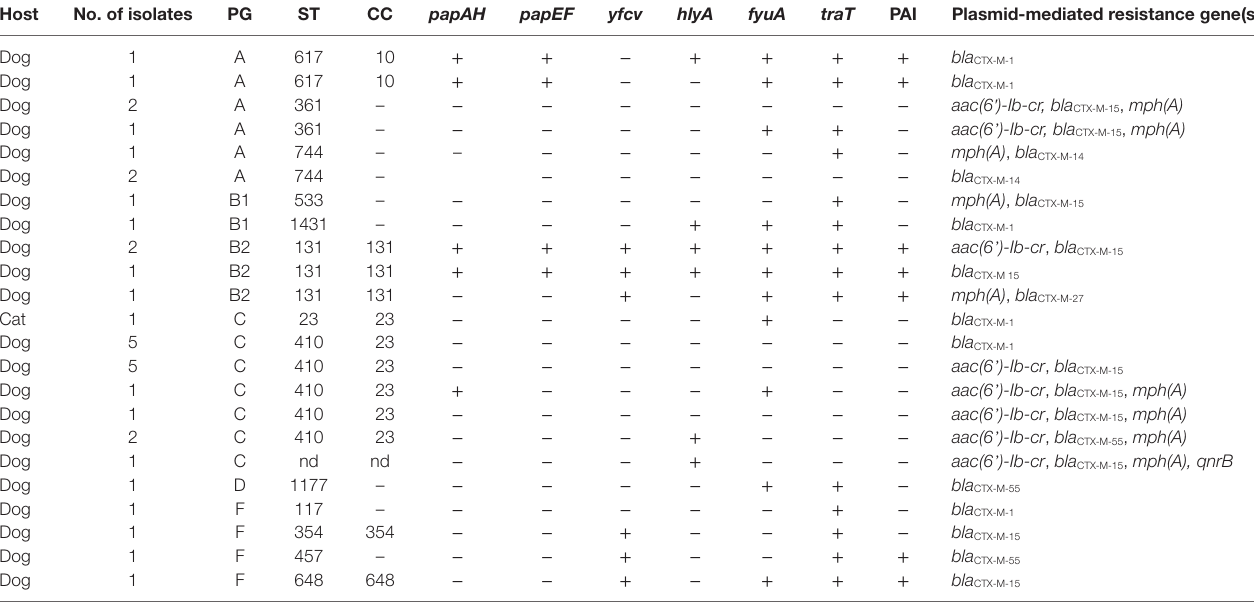
TaBle 4 | Virulence-associated genes detected in 35 uropathogenic extended-spectrum β -lactamases producing Escherichia coli from cats and dogs in Switzerland, 2012–2016. host no. of isolates